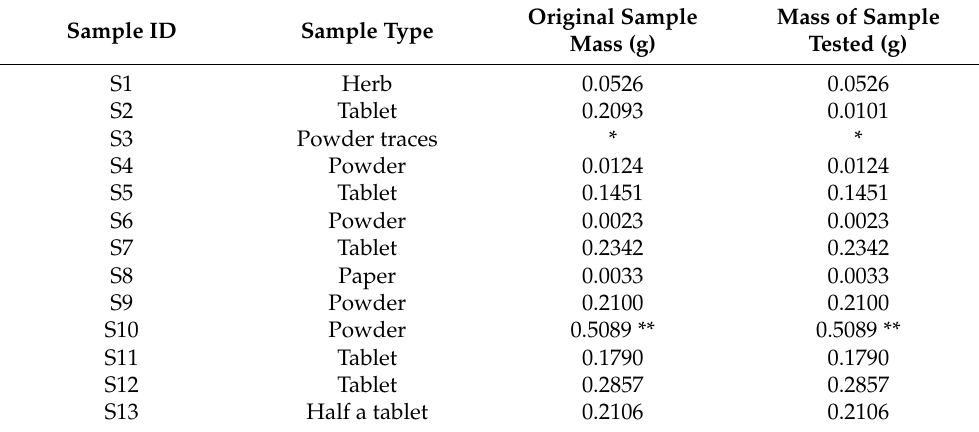
Table 1. Summary of received drug